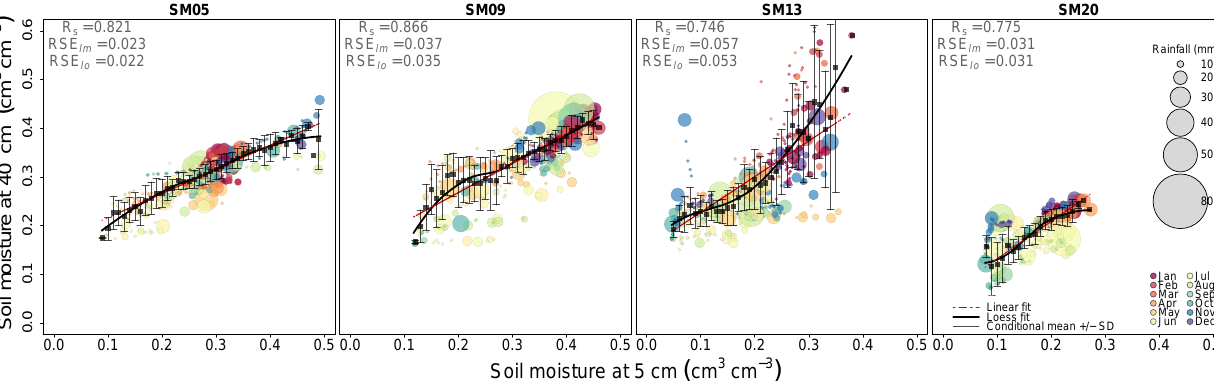
Figure 4. Scatter plots of 5cm vs. 40cm soil moisture values at lag = 0. Colors correspond to the months in a year and sizes of points are proportional to rainfall intensity. Trends along the soil moisture range shown with the fitted loess function (black line). A linear function (red line) is also fitted for comparison. The overall dependence using Spearman’s rank correlation R s is given in the upper left corner of each plot. Residual standard errors (RSEs) for loess (lo) and linear (lm) fits are also